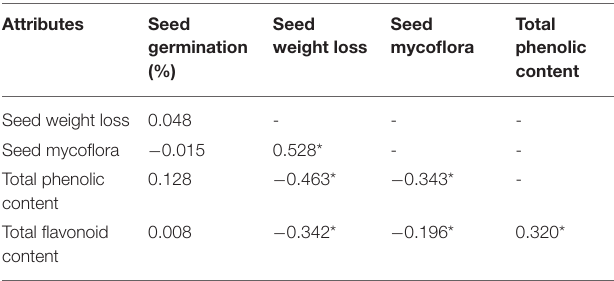
TABLE 3 | Correlation among different parameters of seeds of selected plant species.